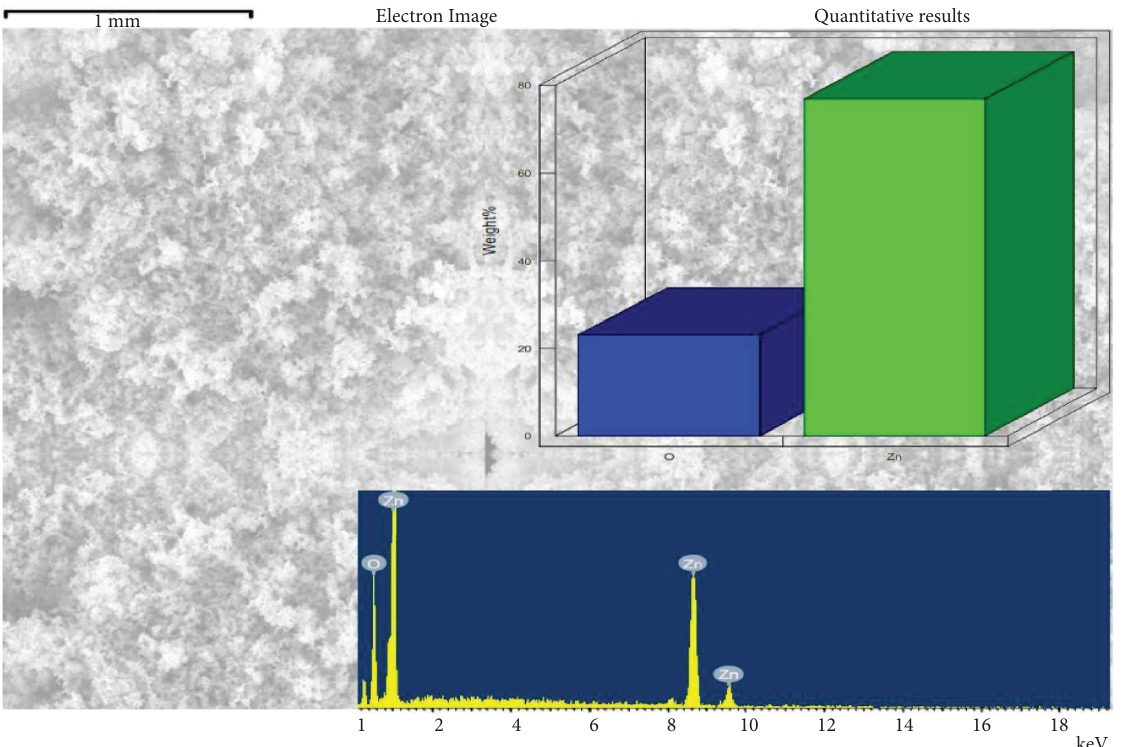
Figure 2: EDX and quantitative analysis of the G-ZnO NPs along with its electron image